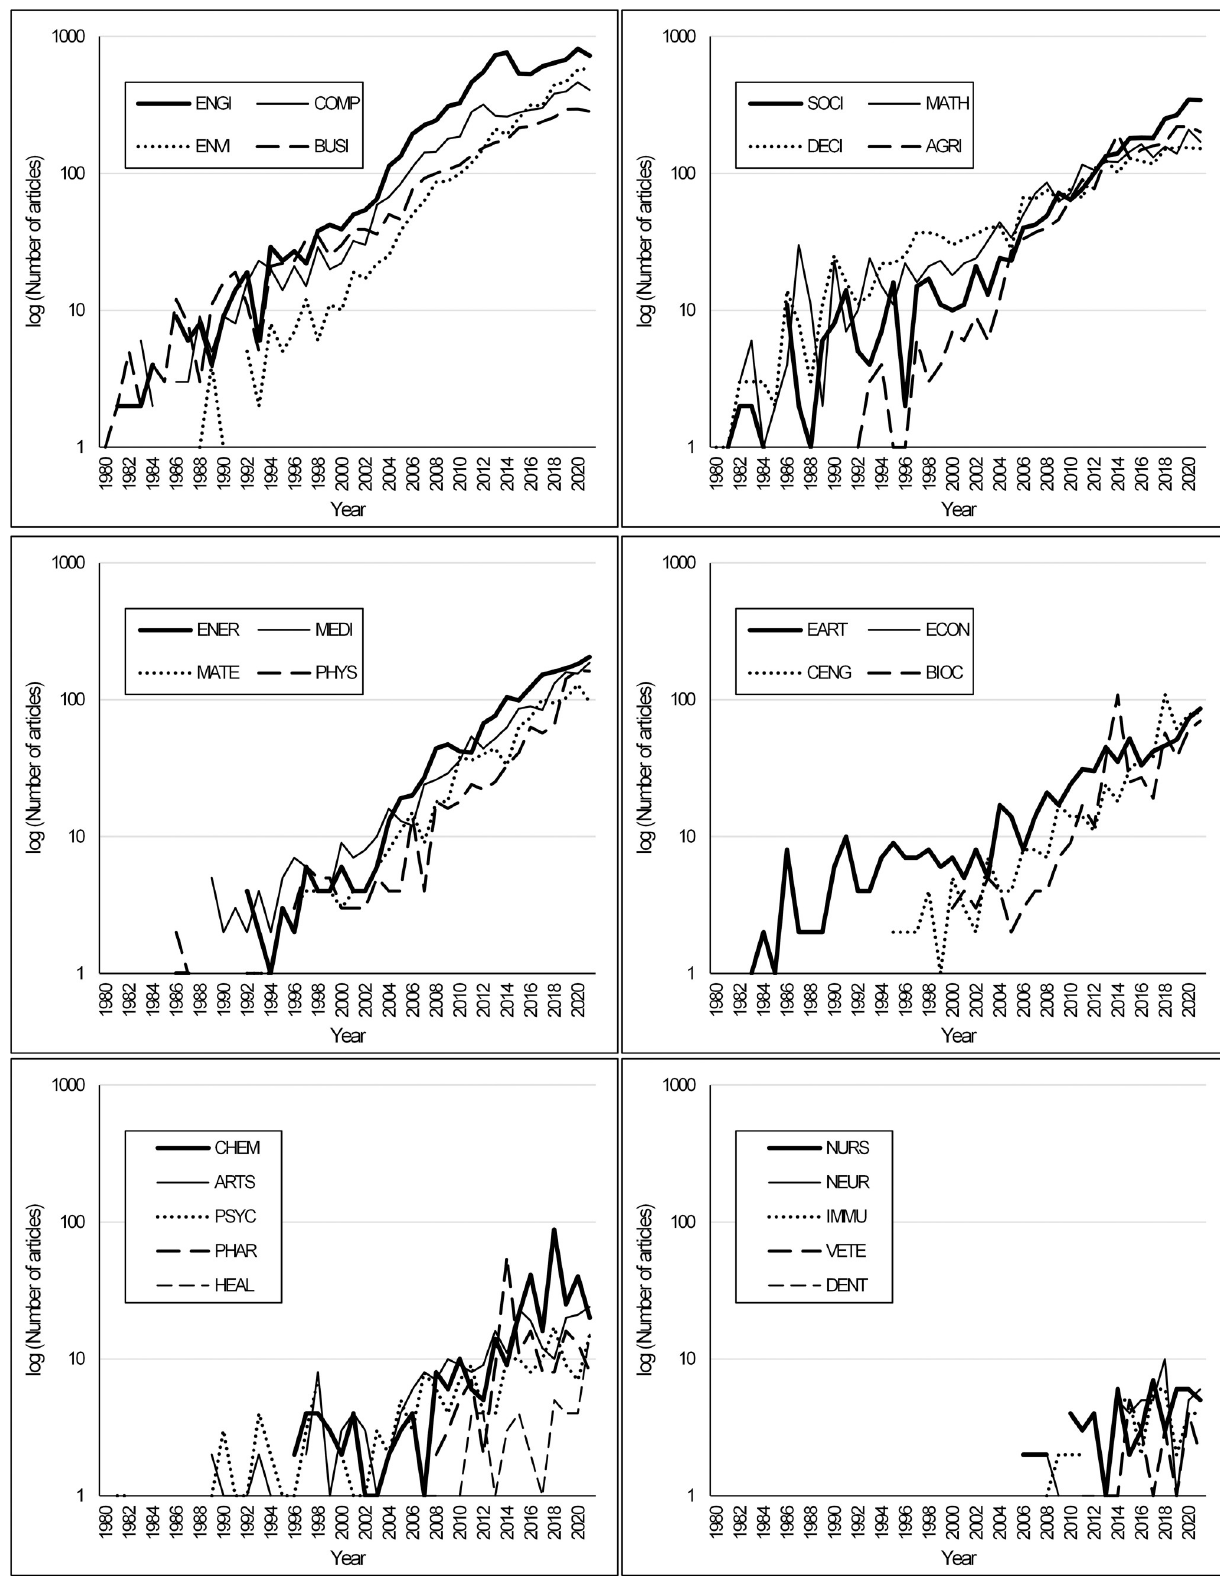
Fig 4. Number of articles development by subject areas. https://doi.org/10.1371/journal.pone.0268777.g004 PLOS ONE | https://doi.org/10.1371/journal.pone.0268777 May 27,